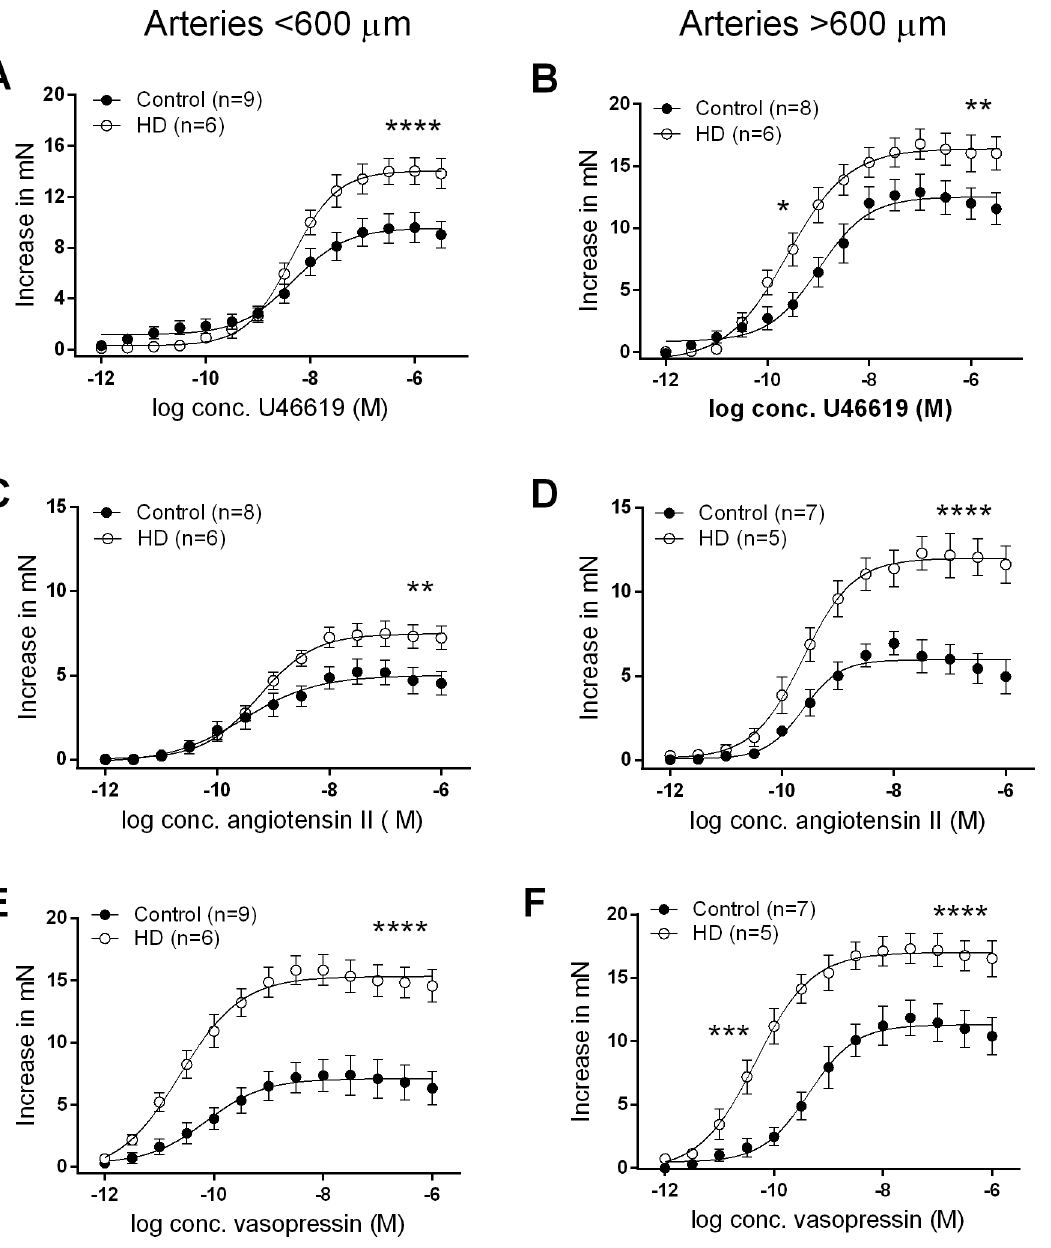
Fig. 2. Concentration-response curves to U46619 (A,B), Ang II (C,D), and vasopressin (E,F) in arteries obtained from HD patients and controls. Data are expressed as mean ¡ SEM and the comparison is by students t-test; ** P , 0.001, *** P , 0.001, **** P , 0.0001. HD, haemodialysis; U4, U46619; n, number of arteries; M, molar; mN,